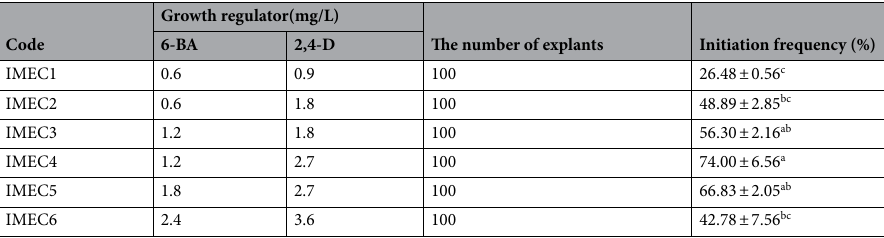
Table 2. Effect of different concentrations of 6-BA, 2,4-D on EC induction from immature zygotic embryo. Bars denote by the same letter within response variables are not significantly different ( P = 0.05) using Duncan’ s multiple range test.